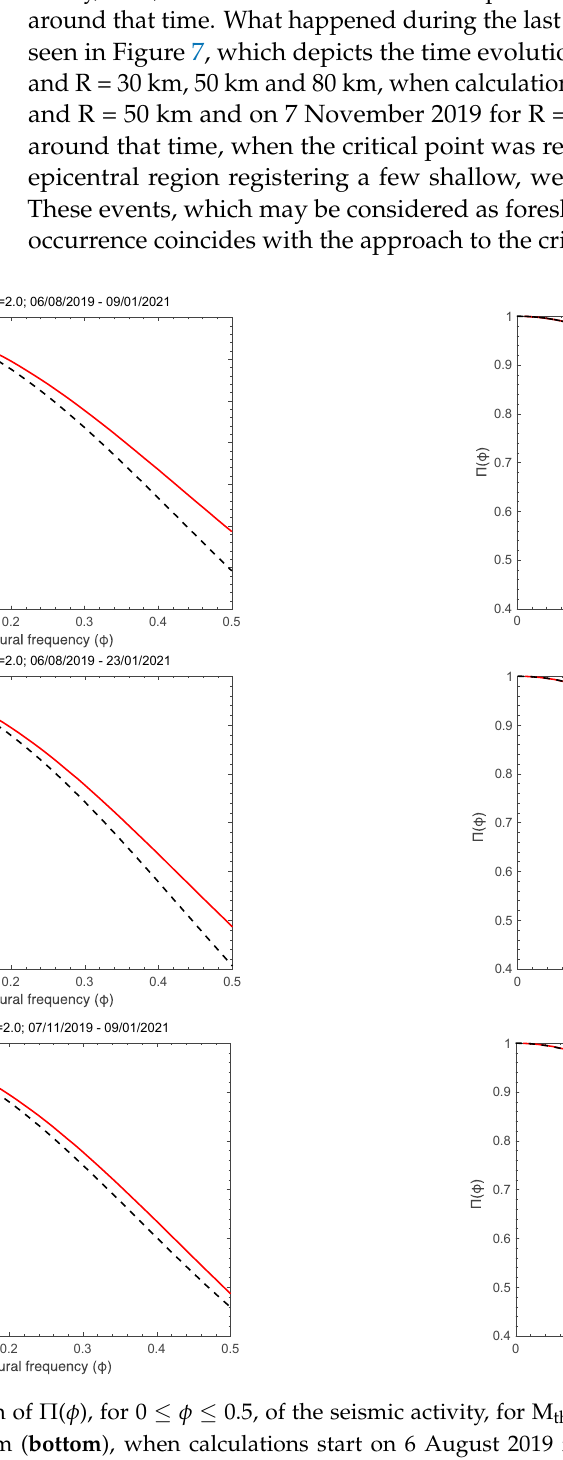
Figure 8. Time evolution of the NT analysis parameters κ 1 , D , S nt and S nt − , in natural time ( left ) and conventional time ( right ), as they evolve event by event prior to the Thessaly M w 6.3 mainshock, considering an area with radius of R = 30 km ( top ), R = 50 km ( middle ), and R = 80 km ( bottom ) around the epicenter and for a magnitude threshold M th = 2.0. The